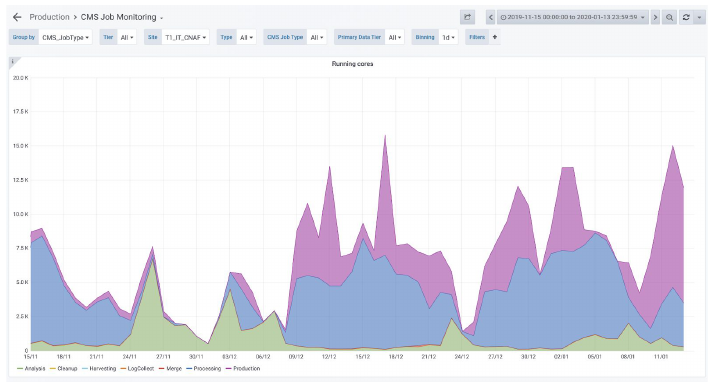
Fig. 5. CMS view of CNAF facility. Since the integration of CINECA has happened as an extension ​ of CNAF, the total number of slots is reported. The violet peaks, with the total number of cores exceeding 15k, are mostly coming from CINECA